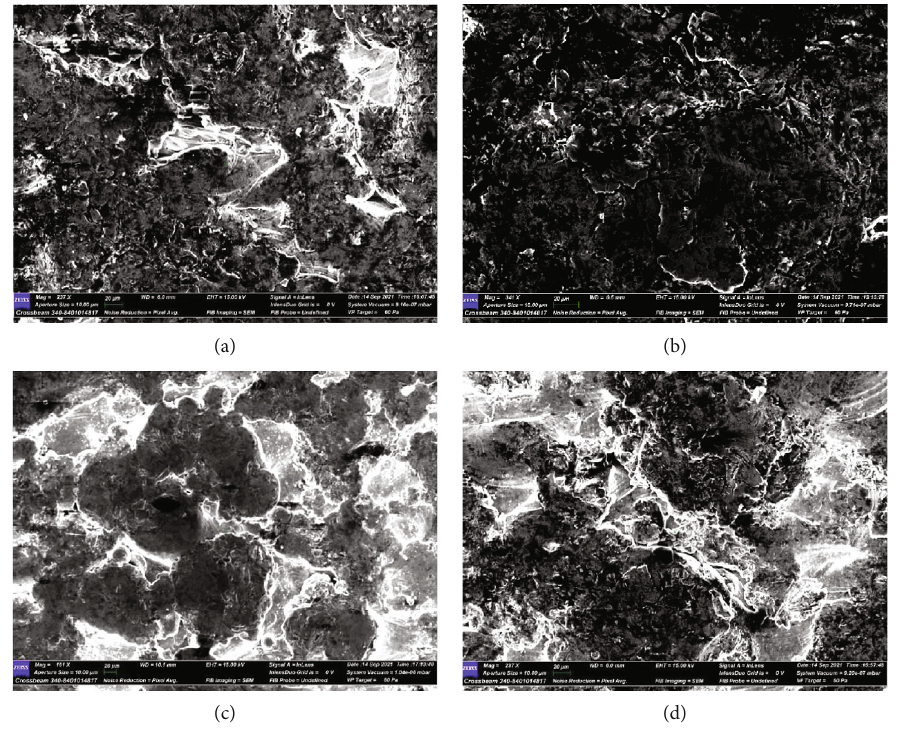
Figure 7: SEM mapping after corrosion: polarization test in NaCl solution (a); polarization test in Ringer ’ s solution (b); immersion test in NaCl solution (c); and immersion test in Ringer ’ s solution (d).